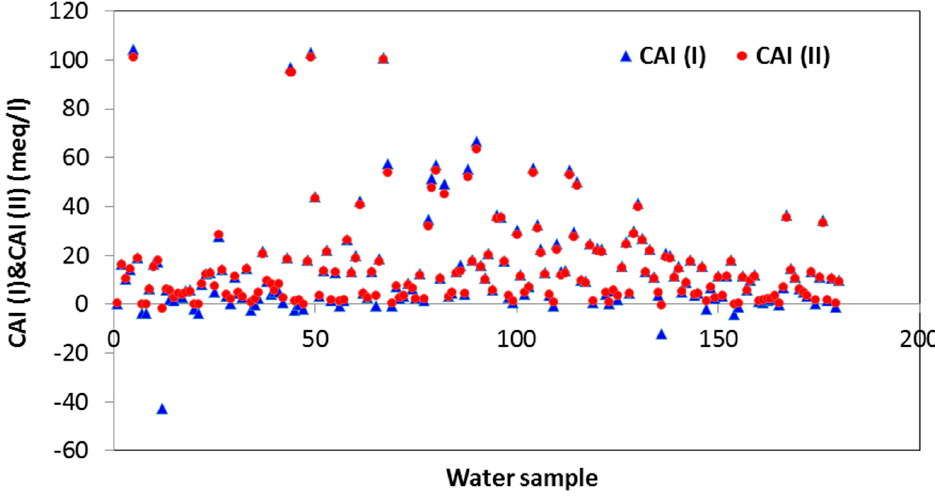
Figure 4. Scatter Plots of CAI-I and CAI-II for groundwater samples from the study area.